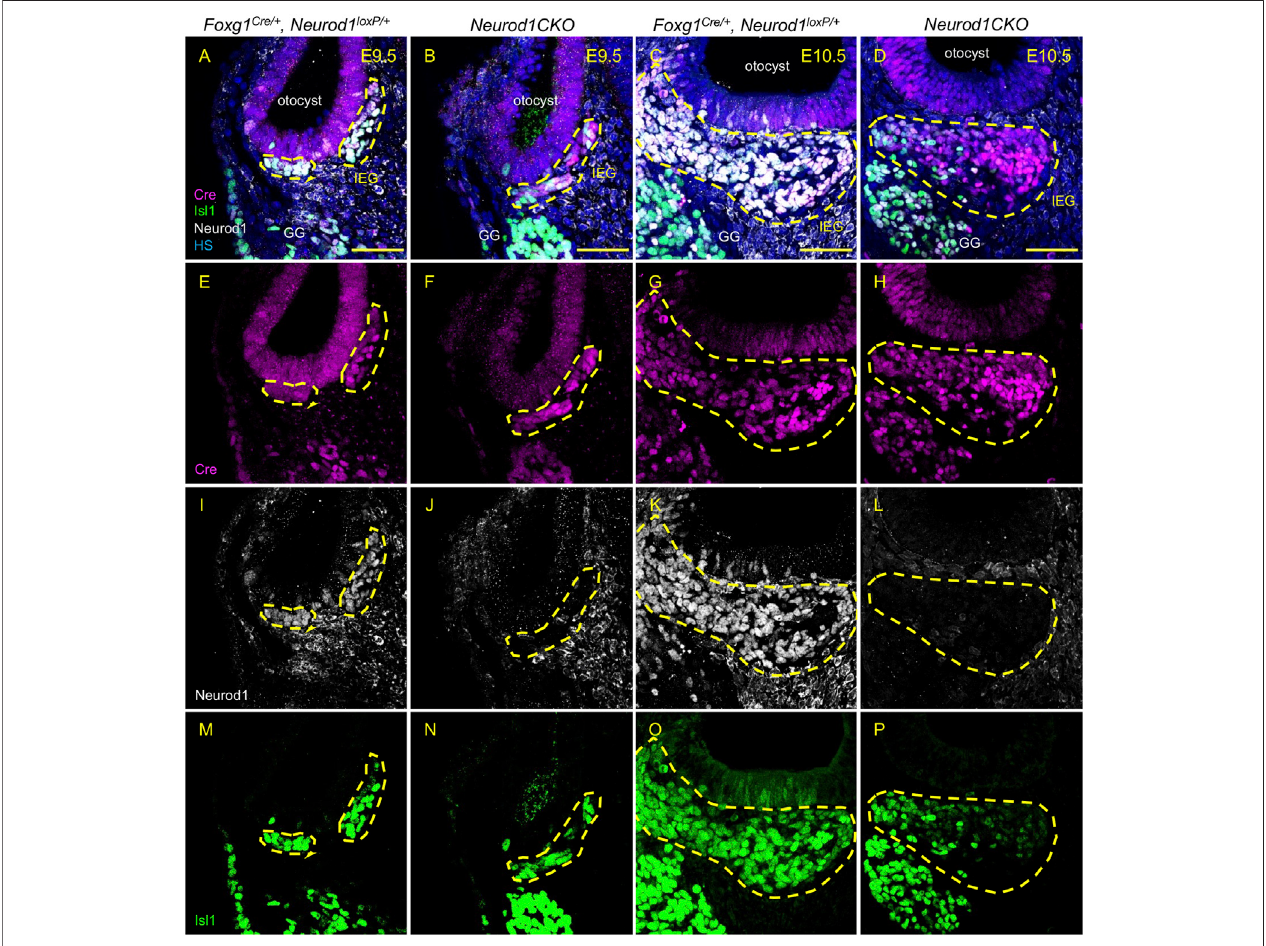
FIGURE3| Ef fi cientelimination of Neurod1 byFoxg1-Creisshown indelaminatingneuroblasts andtheinnerearganglion.Crerecombinase(red) wasdetected as early as E9.5 in mouse Foxg1 Cre/+ otocyst (A , B , E , F) . Neurod1 (white) is eliminated using Foxg1 Cre in mutants at E9.5 (J) as well as at E10.5 (L) , while in controls, NEUROD1isexpressedindelaminatingneurons (I , K) thatareco-labeledbyIsl1antibody(green; M – P ).Theareaoftheinnerearganglionisdelineatedbythedottedline. Scale bars: 50 µm. GG, geniculate ganglion; HS, Hoechst nuclear staining; IEG, inner ear/otic ganglion.